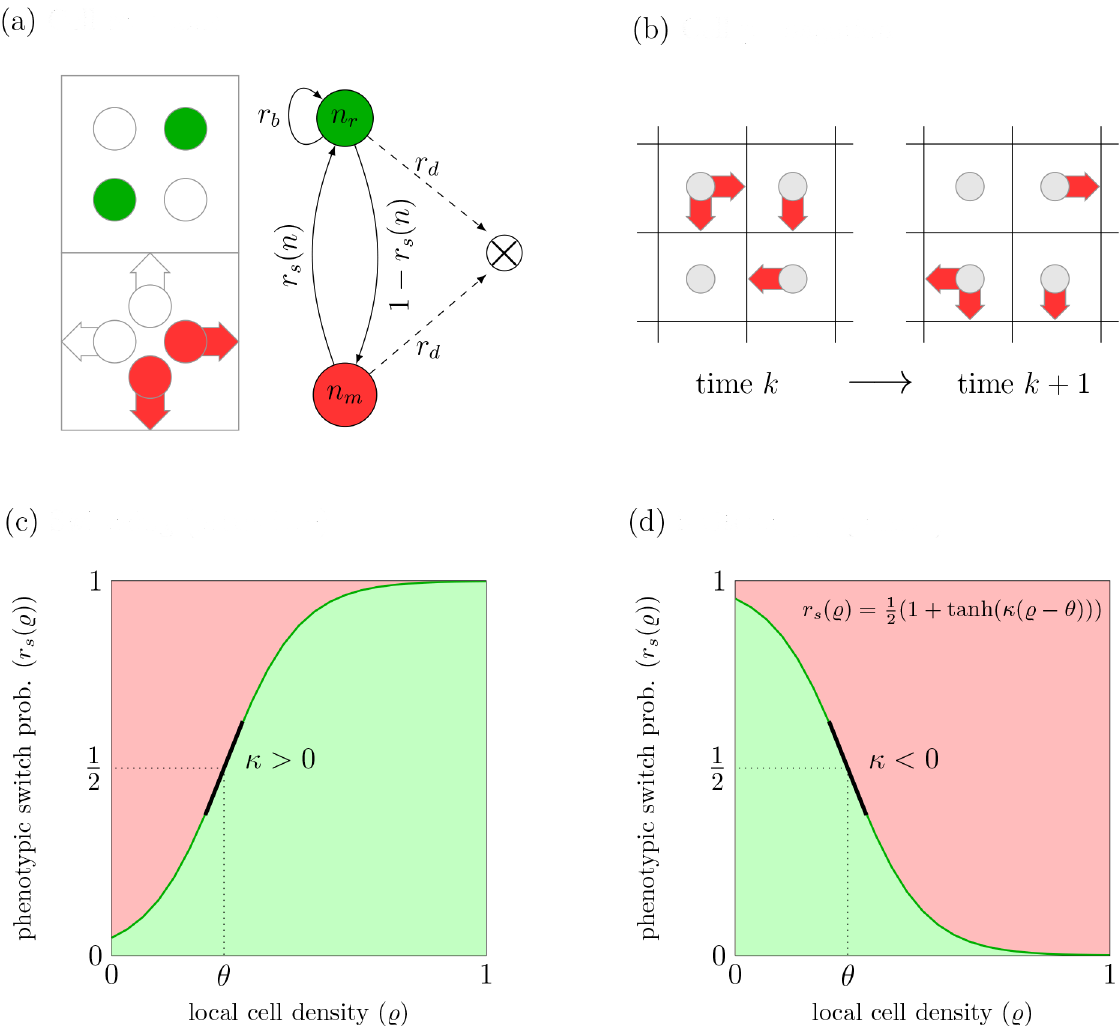
Fig 1. Cellular automaton model dynamics arise from repeated application of cell reactions and cell migration. (a) (left) Local state space at a given node is divided into rest channels and velocity channels. The cells in the rest channels, marked in green, are of proliferative phenotype. The cells in the velocity channels, marked in red, have the migratory phenotype. White channels denote absence of tumor cells. (right) Schematic illustration of model reactions. (b) Example of application of the cell propagation operator in the CA model. Cells in the velocity channels before and after a propagation step; red arrows denote the presence of a cell in the respective velocity channel. (c) and (d) Phenotypic plasticity in the CA model. Schematic illustration of the phenotypic switch probability r s which depends on the cell density % in the microenvironment. The sign of the phenotypic switch parameter κ determines the dynamic regime, κ > 0 results in attractive behavior (c) while repulsive behavior arises for κ < 0